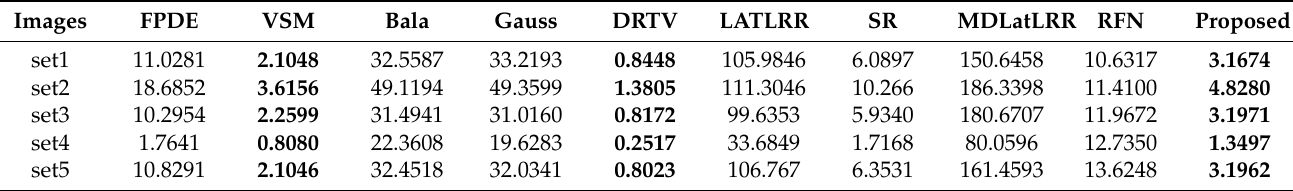
Table 3. Running time T (s) of the ten methods on the TNO dataset.